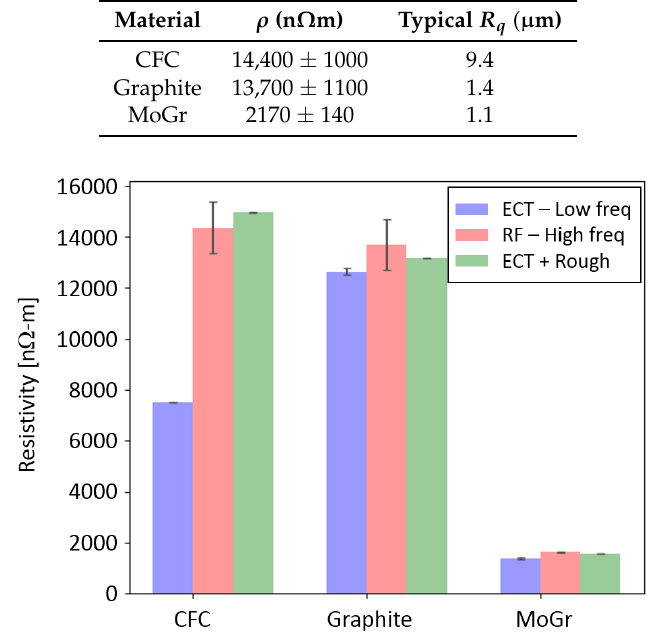
Table 8. In-plane electrical resistivity of CFC, graphite and MoGr measured with the resonant cavity, together with roughness R q parameter [41].